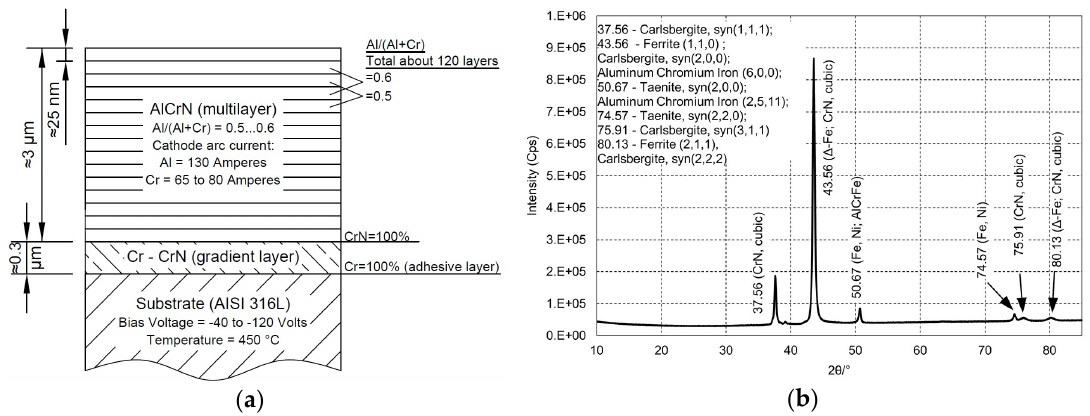
Figure 1. A schematic illustration of the multilayered AlCrN PVD coating on the stainless steel substrate ( a ); and XRD (made by Rigaku Ultima IV , Tokyo, Japan) diffractogram of AlCrN PVD coating deposited onto stainless steel AISI 316L substrate, indicating a dominating cubic CrN phase in the coating ( b ).